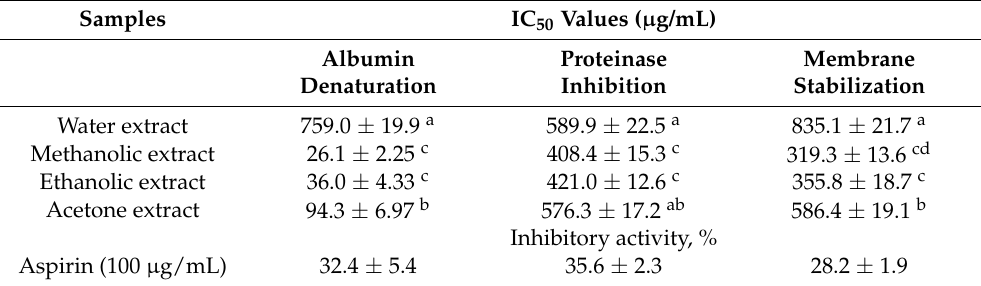
Table 5. In vitro anti-inflammatory activity of different Caralluma edulis extracts.